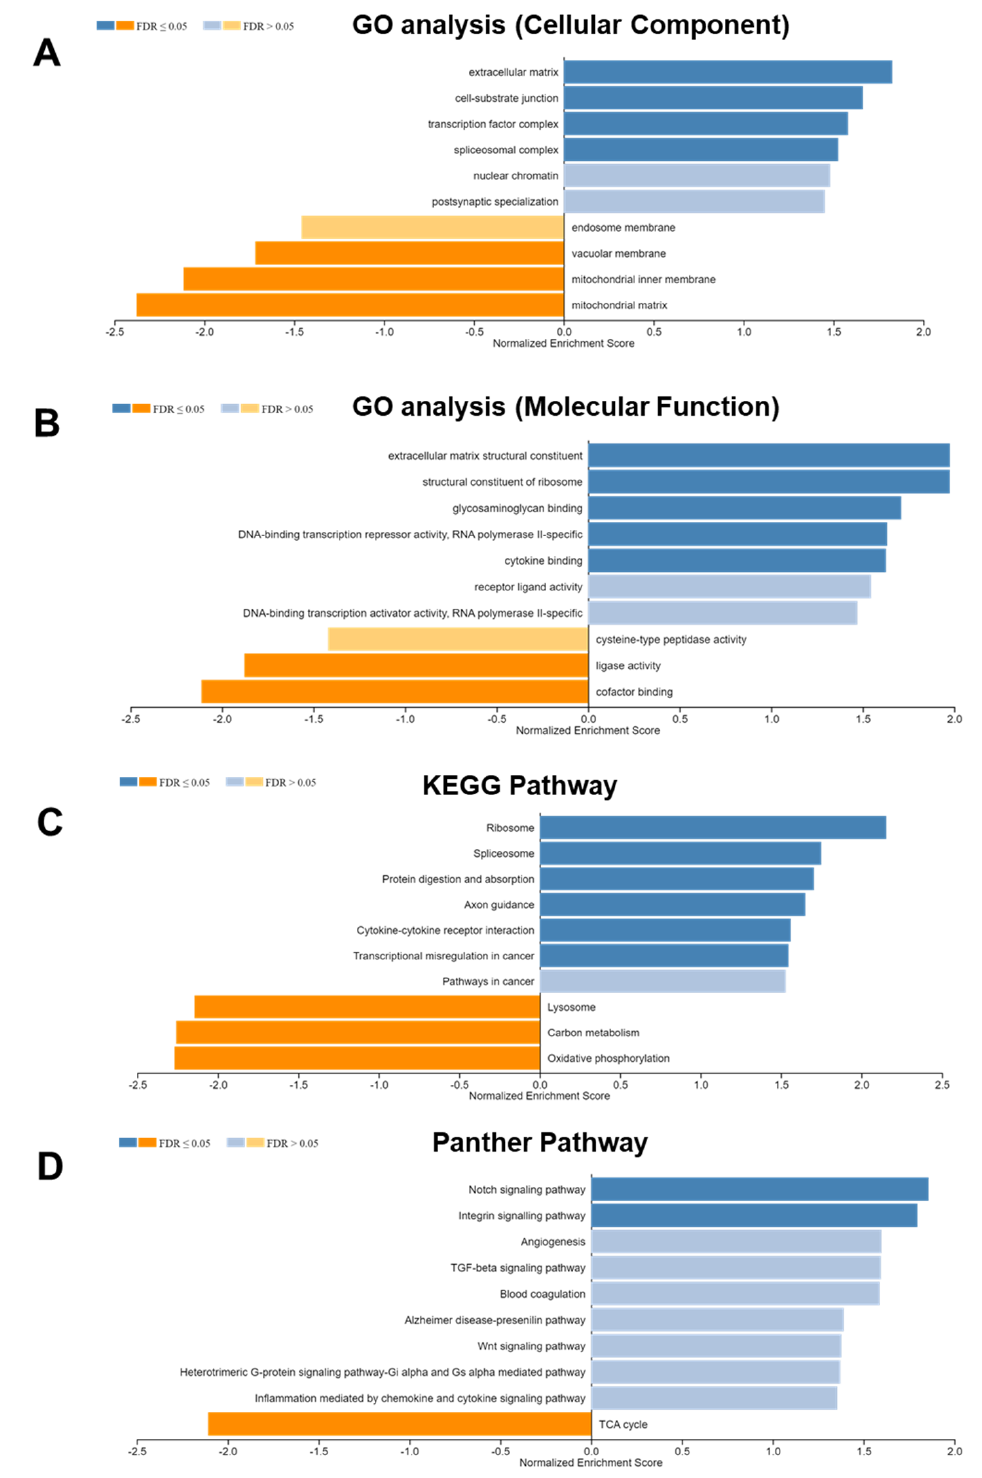
Figure 8. The gene sets positively and negatively correlated with the DLK2 level in ccRCC are identified using the LinkedOmics tool. The ( A , B ) GO, ( C ) KEGG, and ( D ) Panther pathways analyses for DLK2 in ccRCC. The blue bars indicate the gene clusters positively correlated with DLK2. The orange bars indicate the gene clusters negatively correlated with DLK2.